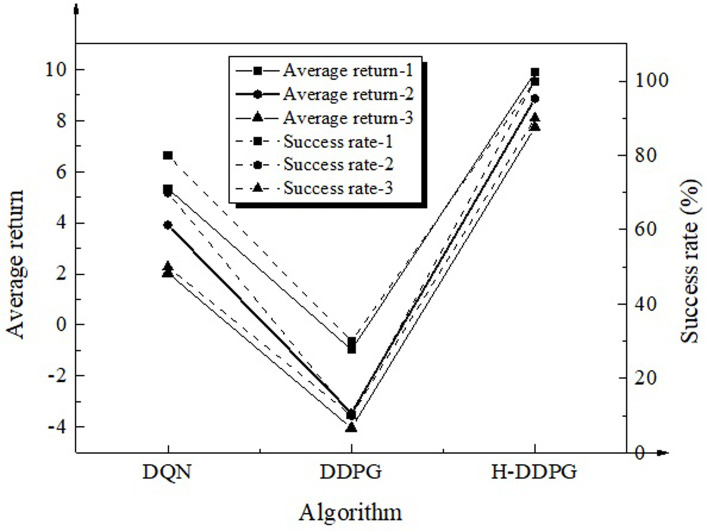
Comparison of optimal test results between H-DDPG algorithm and other algorithms.